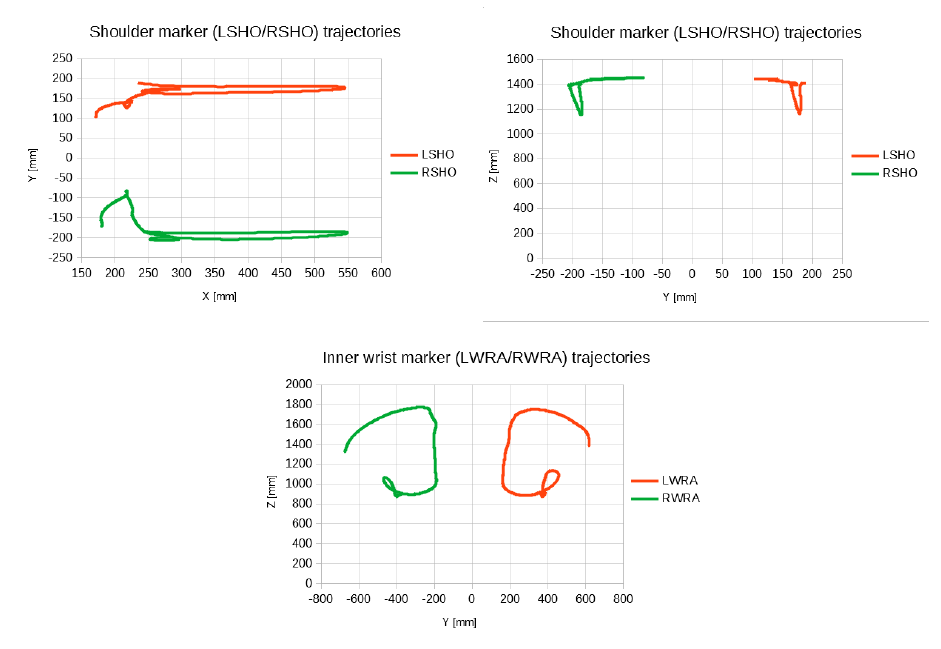
Figure 4. Trajectories for upper body parts for the first sequence.